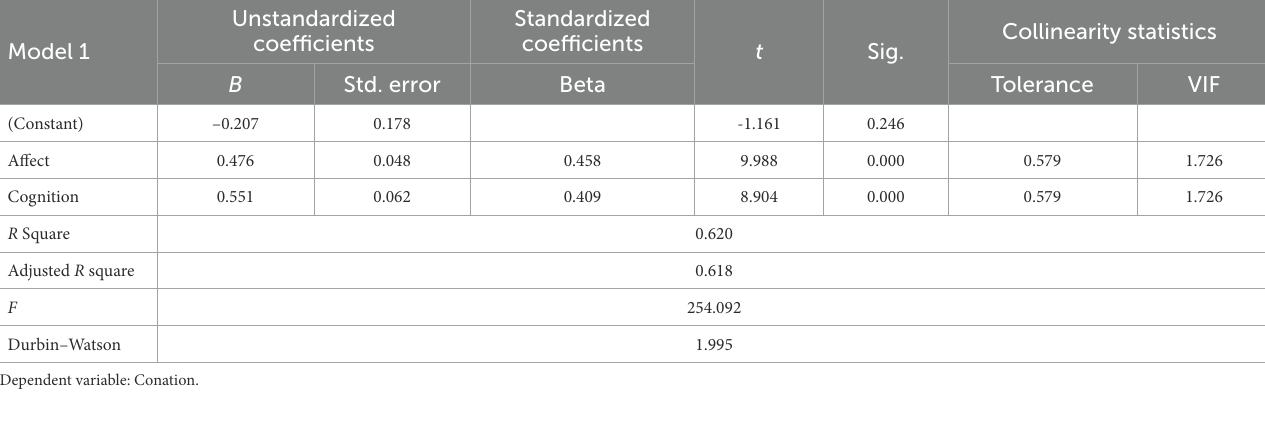
TABLE 6 Regression analysis of predictive variables and affect. a